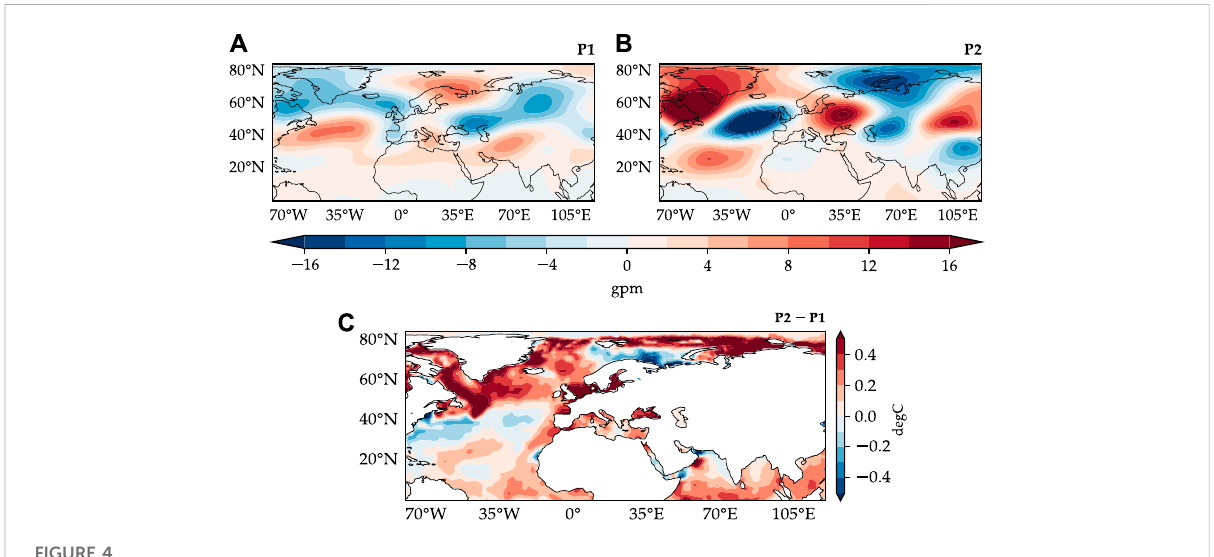
FIGURE 4 Composites of 200 hPa eddy geopotential height fi eld during the two AMO warm epochs (A) , P1 (1926 – 1961) and (B) P2 (1999 – 2012); (C) Difference between SST composites for the two epochs